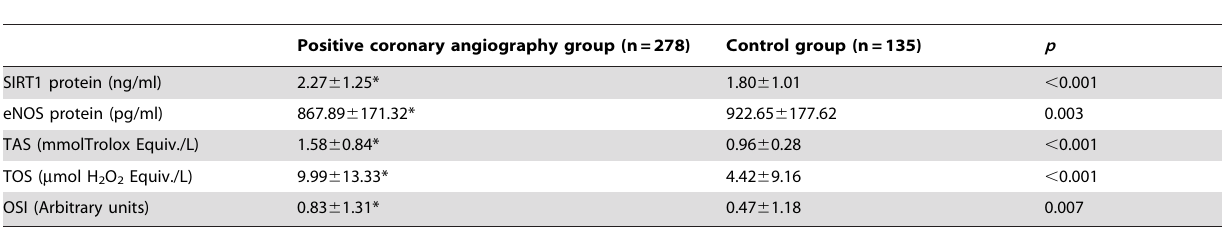
Table 3. Comparison of SIRT1, eNOS protein, TAS, TOS and OSI levels in study population.